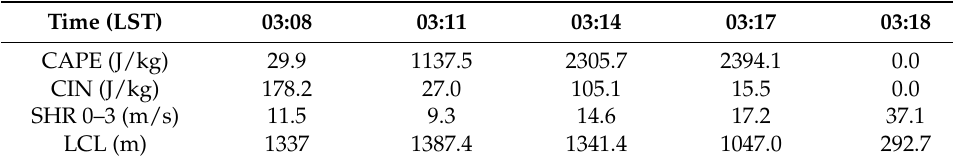
Table 1. The modified sounding T-lnp physical quantity table of Kaiyuan station.